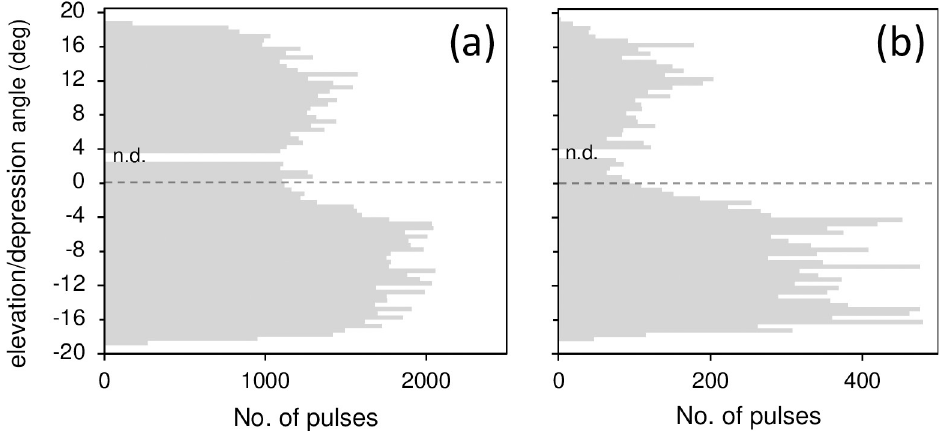
Fig 4. Frequency distributions of elevation/depression angle for (a) all pulses recorded and (b) the foraging sequences for harbour porpoises by the A-tag in the gillnet set-up during the present study. Pulses with an elevation/depression angle between 2.5˚ and 3.5˚ were